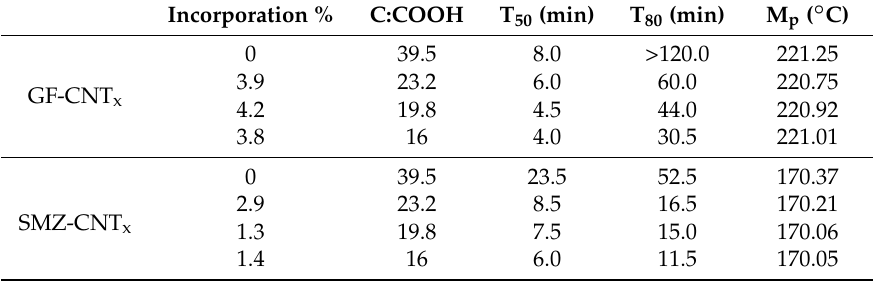
Table 2. Dissolution and melting point of sulfamethoxazole-CNTs (SMZ-CNTs) and griseofulvin-CNTs (GF-CNTs).